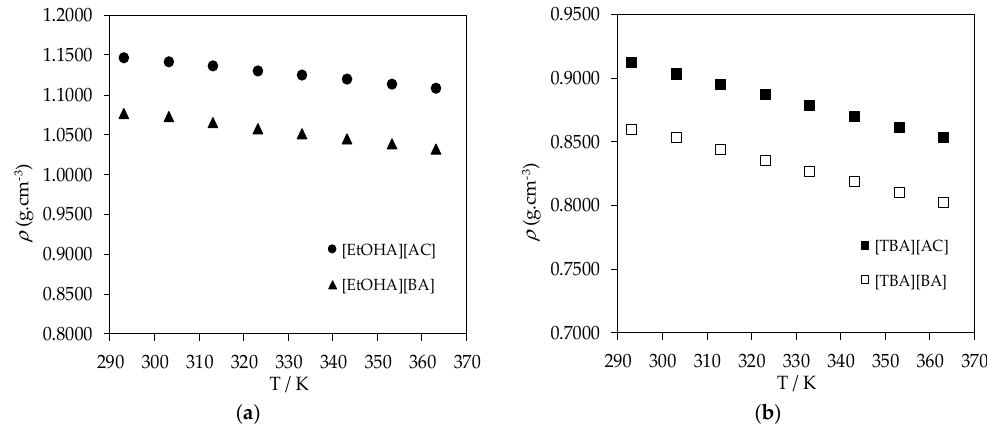
Figure 2. ( a ) Plot of experimental density ( ρ ) values of [EtOHA][AC] and [EtOHA][BA] and ( b ) plot of experimental density ( ρ ) values of [TBA][AC] and [TBA][BA] as a function of temperature.